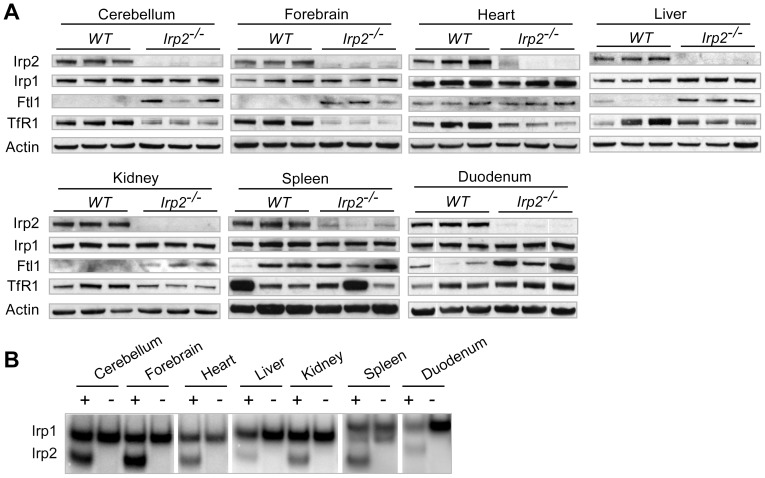
Expression of iron homeostasis proteins in Irp2−/− and WT mice.
A) Western blot analysis of tissue extracts from male Irp2−/− and WT mice (n = 3 mice/genotype) using antibodies to detect Irp2, Irp1, ferritin (Ftl1), TfR1 and β-actin (loading control). A non-specific band migrating near Irp2 is observed in some Irp2−/− lysates. B) Irp1 and Irp2 RNA-binding activity in lysates was assayed by RNA electrophoretic mobility shift assay using a 32P-labeled ferritin IRE as a probe. 0.5% β-mercaptoethanol was added to samples to assay total RNA-binding activity.